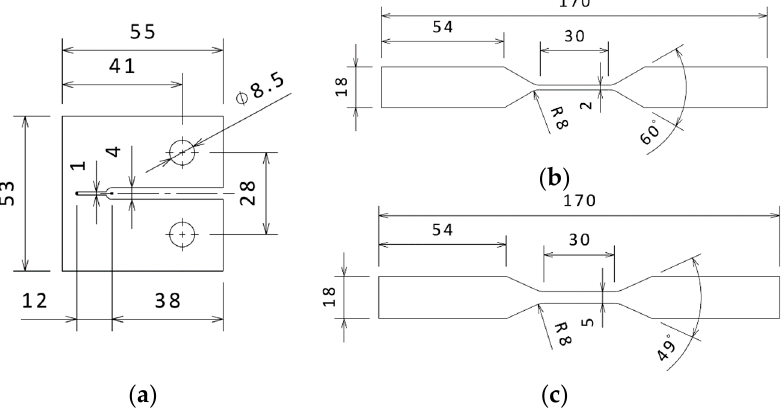
Figure 1. Geometry of the tested specimens [mm]: ( a ) BRCT, CPCT, and UCT samples; ( b ) CPT sample; ( c ) CPTS sample.